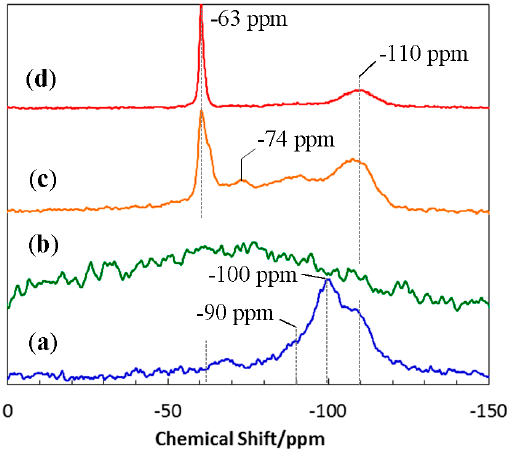
Figure 4. 29 Si-NMR spectra of ( a ) 800 °C-pyrolysed EtOSZ and the samples after the subsequent heat treatment at ( b ) 1400 °C; ( c ) 1600 °C; and ( d ) 1800 °C in N 2 . One broad peak at around − 100 ppm was deconvoluted to three broad peaks centered at − 110,